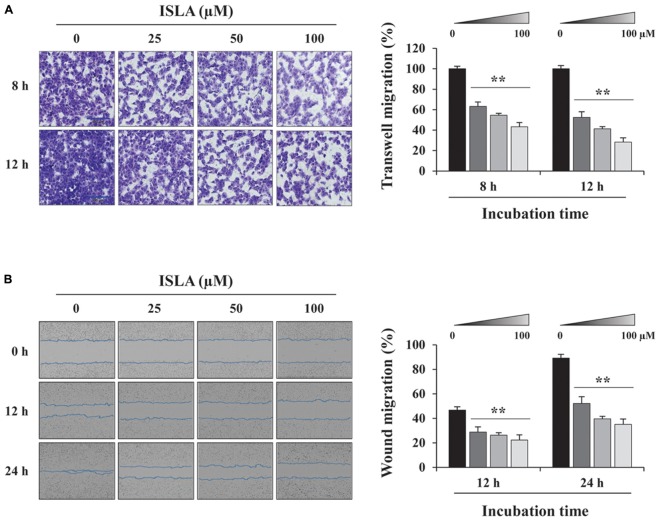
Isoliquiritin apioside suppressed the migration of HT1080 cells. (A) HT1080 cells were pretreated with or without ISLA for 12 h and then subjected to migration across a Transwell® membrane. After 8 and 12 h, the number of migrated cells in five random fields was counted using phase contrast inverted microscopy after staining with Crystal Violet solution. Relative migration compared with untreated control cells was calculated and expressed as the mean ± SD (n = 5). Data are representative of three independent experiments. (B) After inflicting injury wounds in HT1080 cell layers using a 96-pin wound maker, cells were treated with or without ISLA and then monitored every 3 h using an IncuCyte Zoom. The relative wound migration in each group at 12 and 24 h was calculated based on the wound width at 0 h using ImageJ software. Data are expressed as the mean ± SD obtained from triplicate samples. ∗∗p < 0.01 vs. ISLA-untreated control.